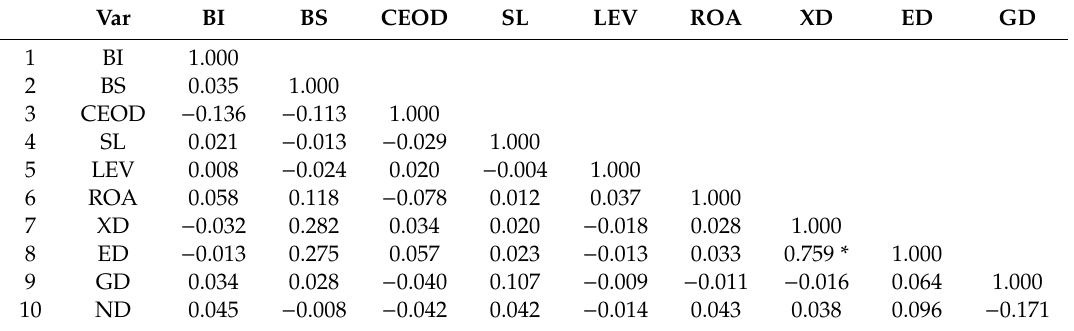
Table 4. Correlation Matrix (Sample Size = 175, N =